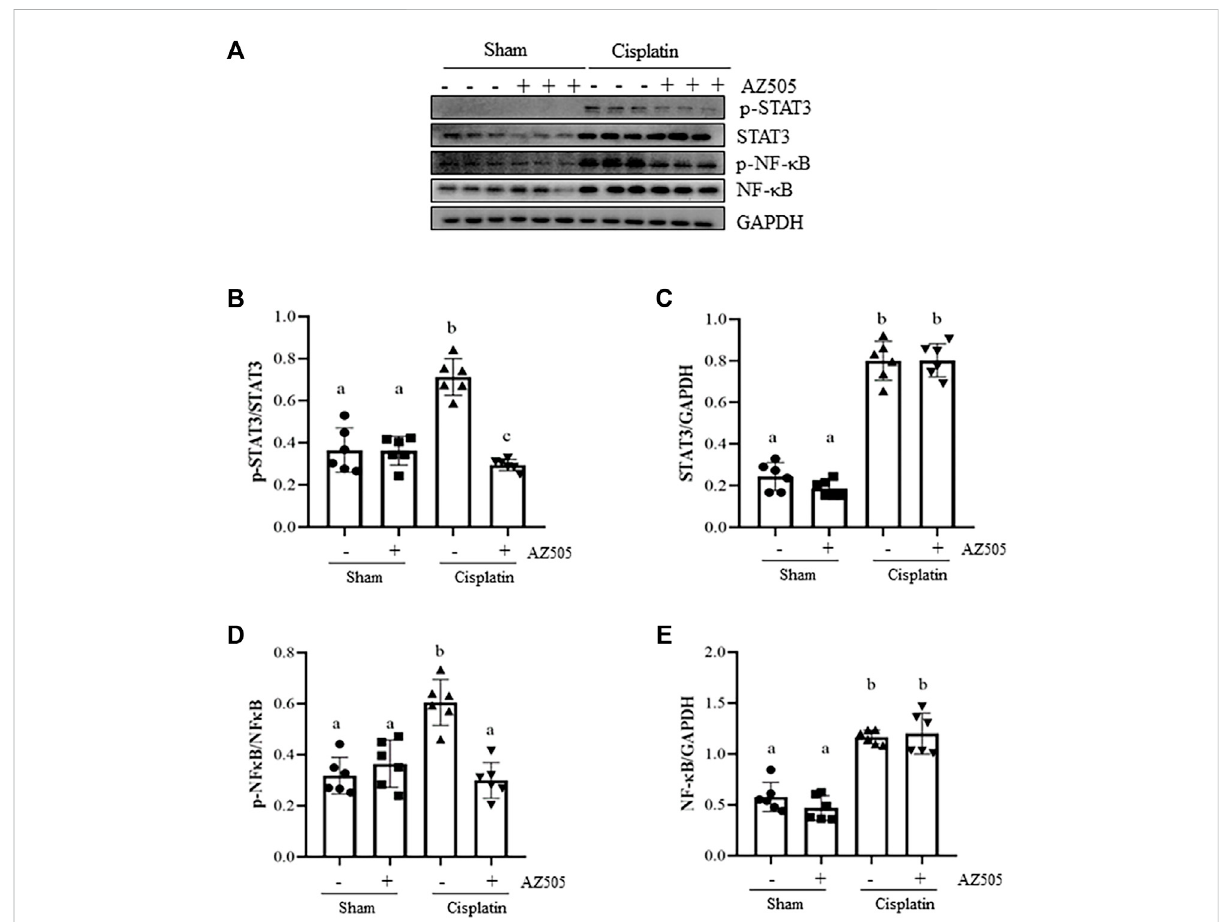
FIGURE 7 Administration of AZ505 blocks phosphorylation of STAT3 and NF- κ B induced by cisplatin. (A) The kidney tissues were taken for immunoblot analysis of phospho-STAT3 (p-STAT3), phospho-NF- κ B (p-NF- κ B), total STAT3, total NF- κ B, and GAPDH as indicated. Representative immunoblots from 3 experiments are shown. (B,D) Expression levels of p-STAT3 (B) and p-NF- κ B (D) were quanti fi ed by densitometry and normalized with total STAT3 and NF- κ B as indicated, respectively. (C,E) Expression levels of total STAT3 (C) and NF- κ B (E) was quanti fi ed by densitometry and normalized with GAPDH as indicated, respectively. Data are means ± S.E.M. (n = 6). Means with different superscript letters are signi fi cantly different from one another ( p <